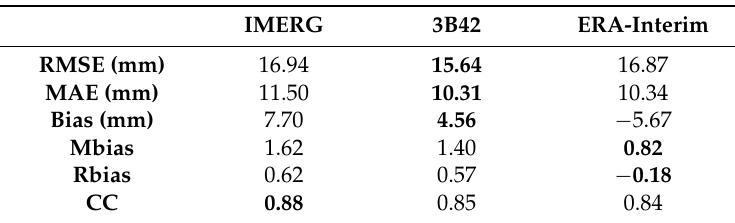
Table 10. Statistical indices of monthly precipitation in Kermanshah area (mid-March 2014 to February 2015).